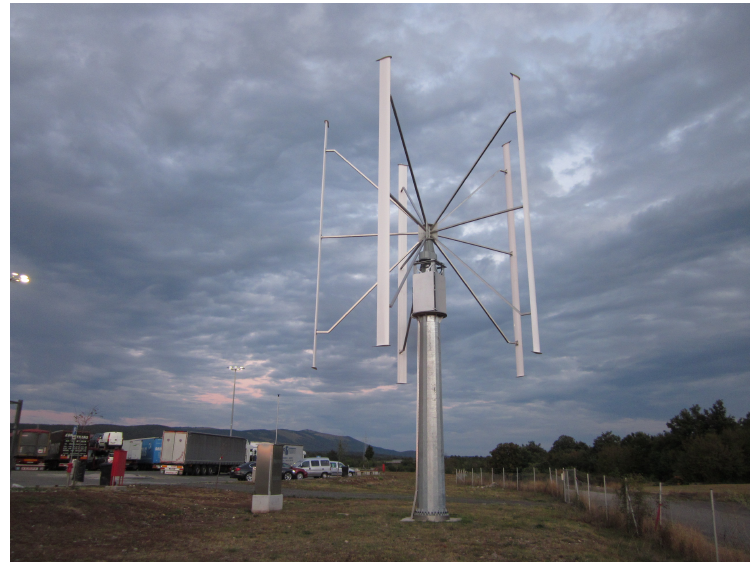
Figure 1. A small wind turbine. Photo by Marija Zlata